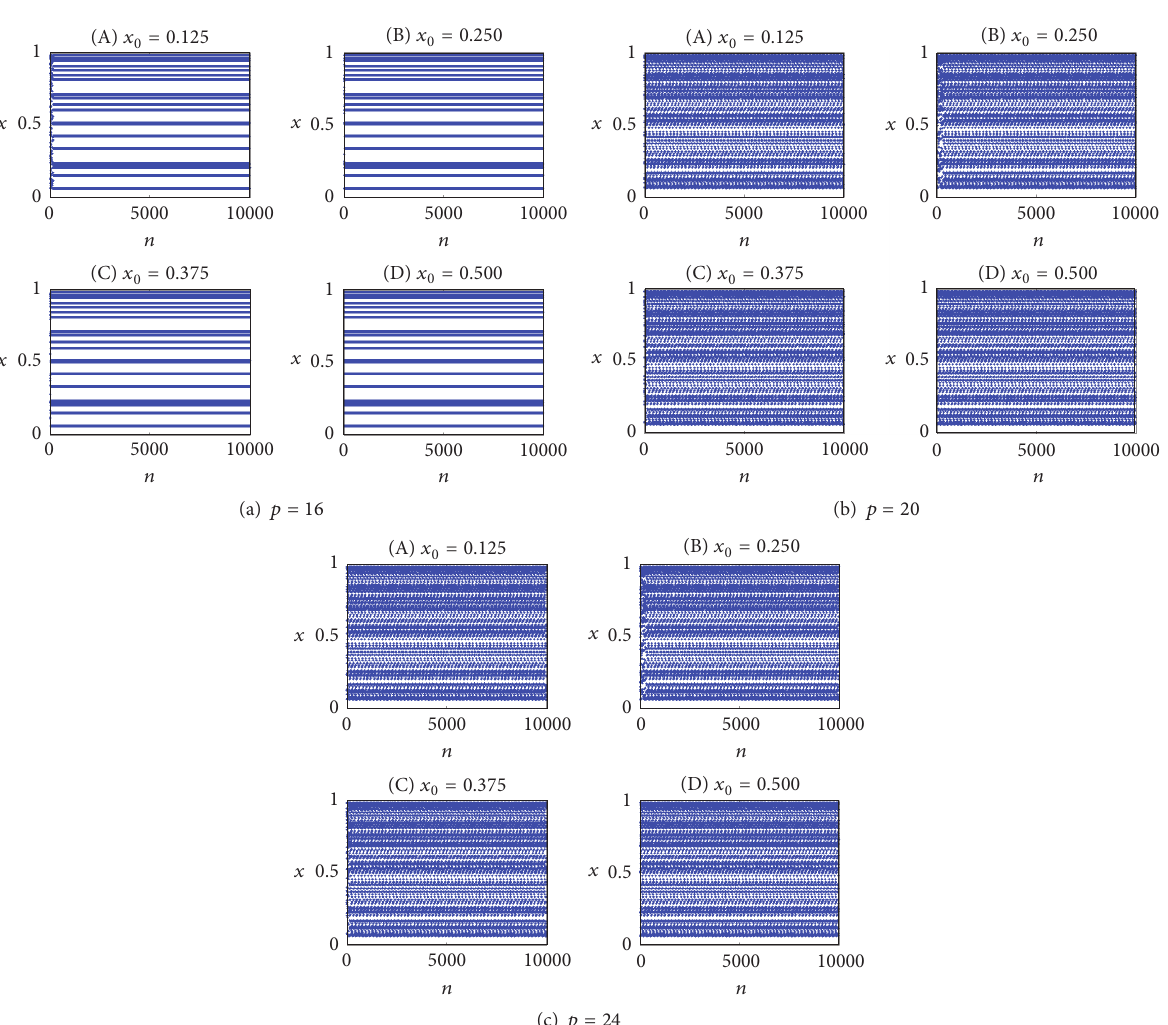
Figure 9: Time series of 𝑓 3 (𝑥) at 𝜆 = 3.9375 starting at different initial conditions and various